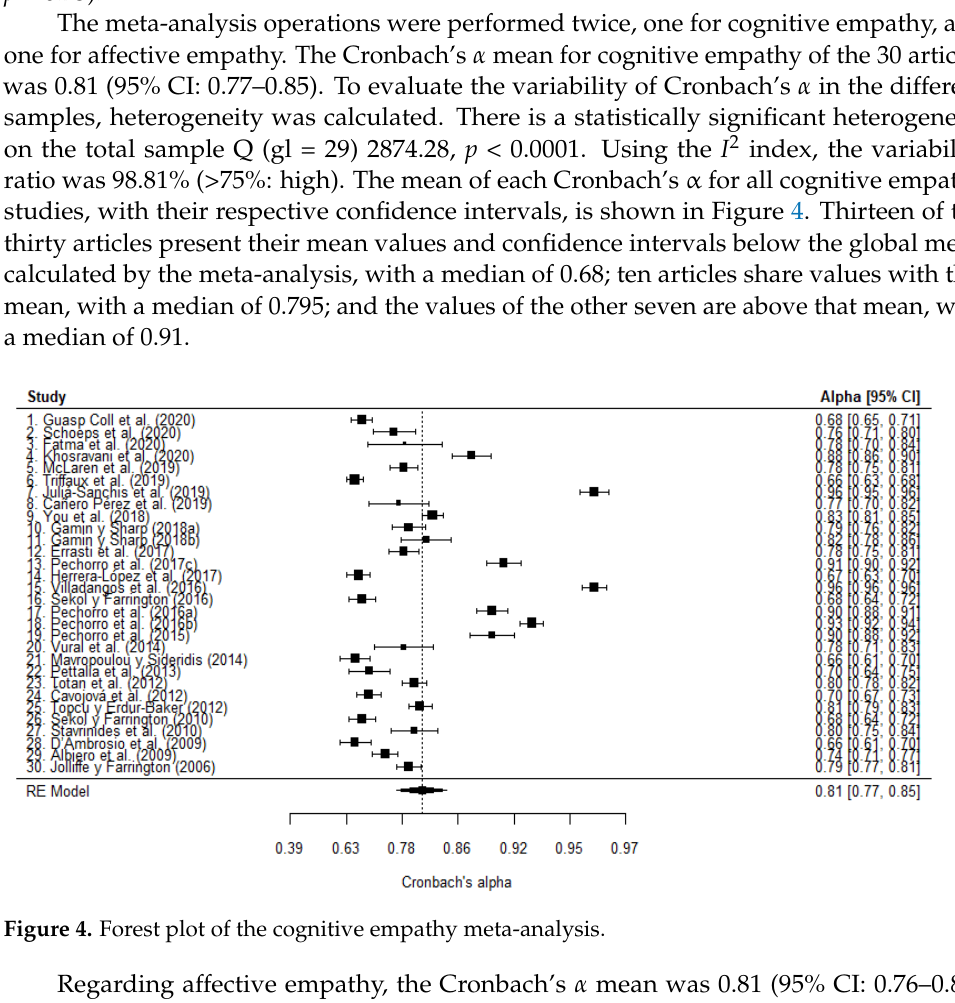
Table 3. Figure 5. Forest plot of the affective empathy meta-analysis.